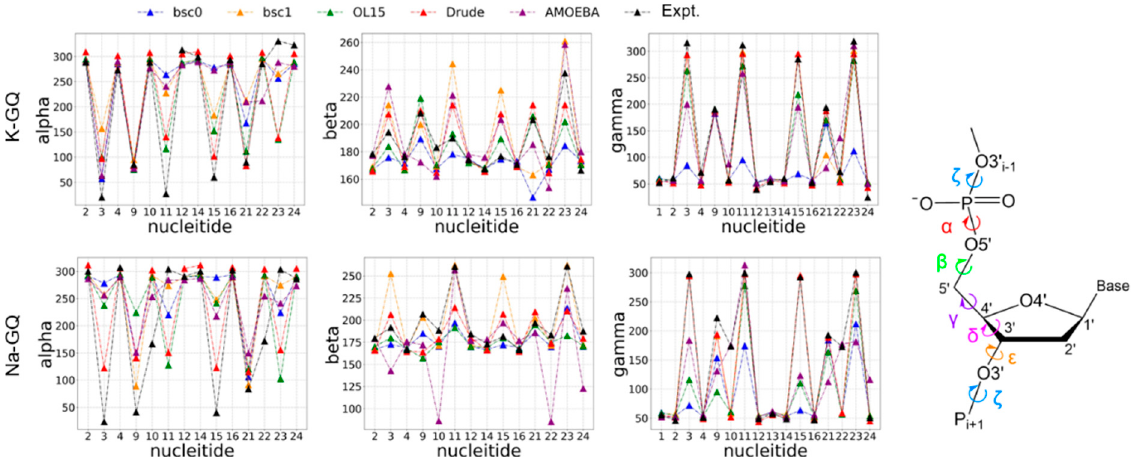
Figure 7. Average dihedral angle of guanine deoxyribonucleotides in replication 1 calculated from 20,000 snapshots randomly extracted from the MD trajectories of K ‐ GQ (upper panel) and Na ‐ GQ (bottom panel), respectively. The experimental values are also shown for comparison.